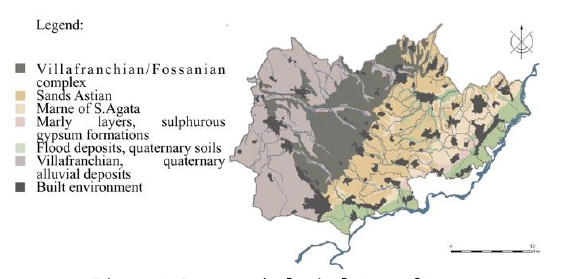
Figure 1. Geomorphological Map of Roero, reworked by the